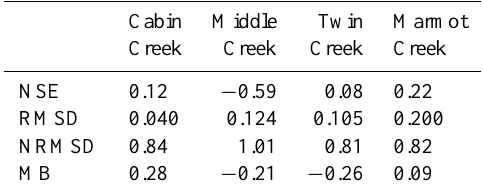
Table 7. Nash–Sutcliffe efficiency (NSE), root mean square